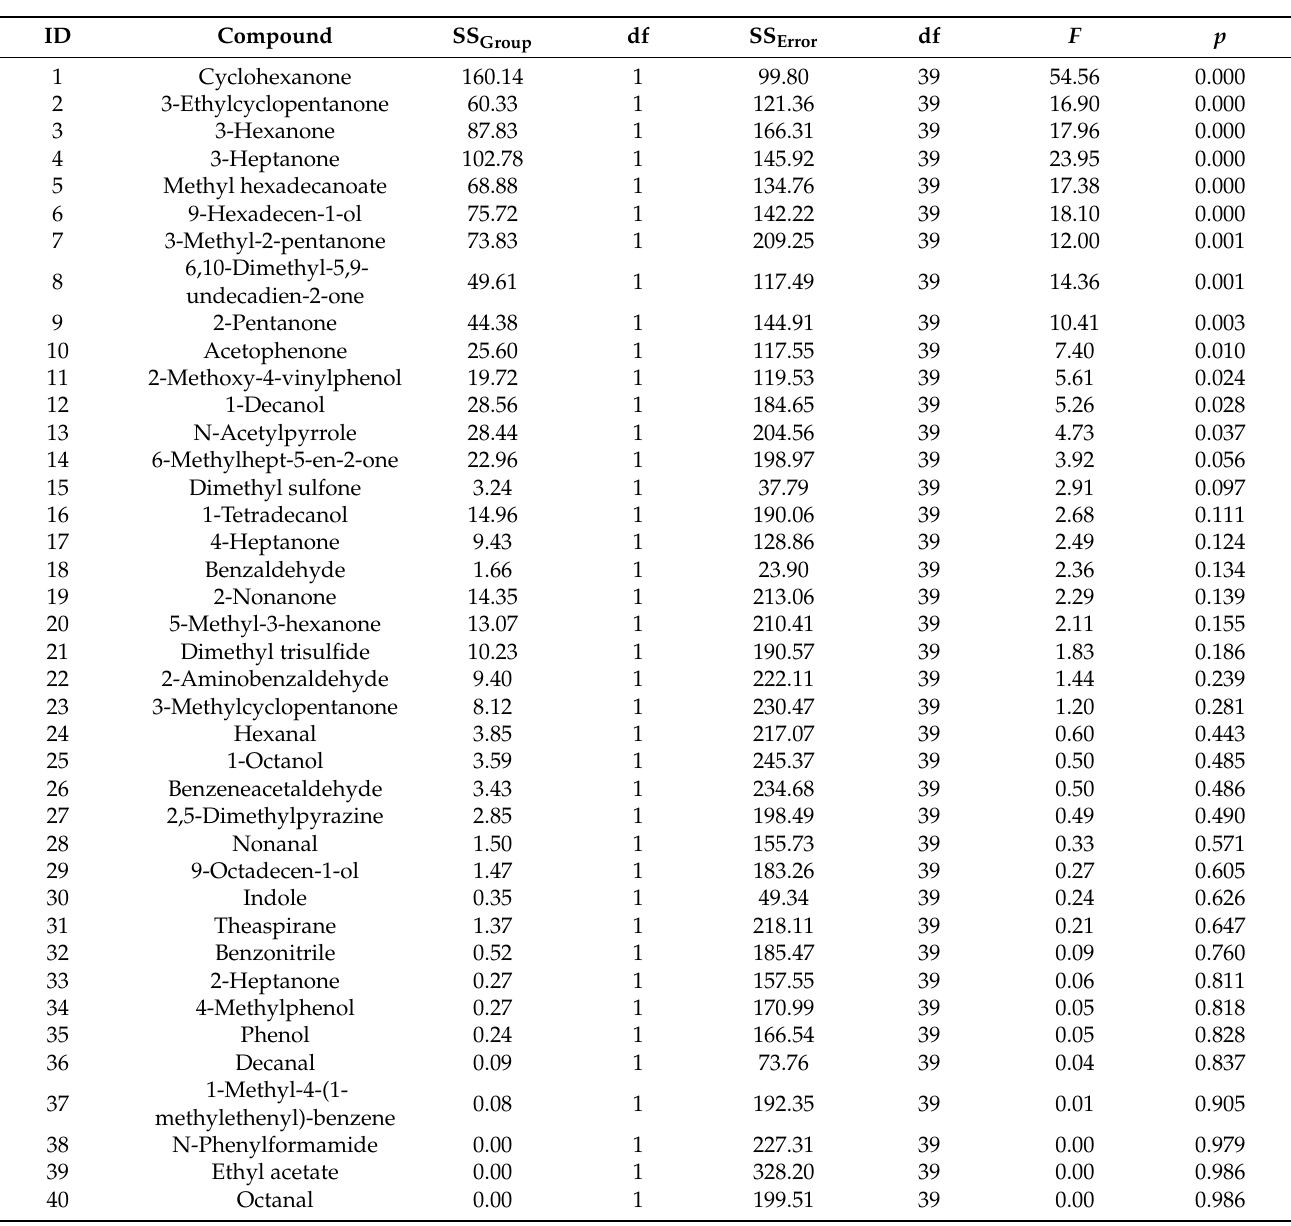
Table 1. ANOVA grouping results of VOC in k-mean analysis (disease group vs. control). where: SS Group–squared